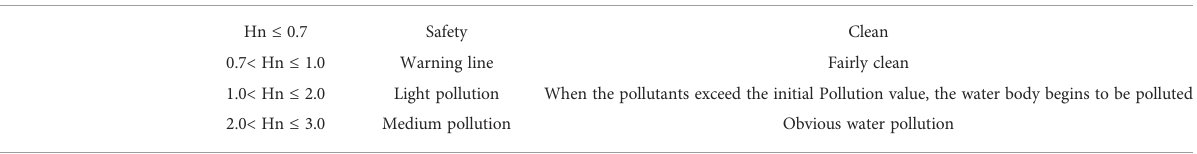
TABLE 2 Classi fi cation criteria for Nemero composite index (Hn).